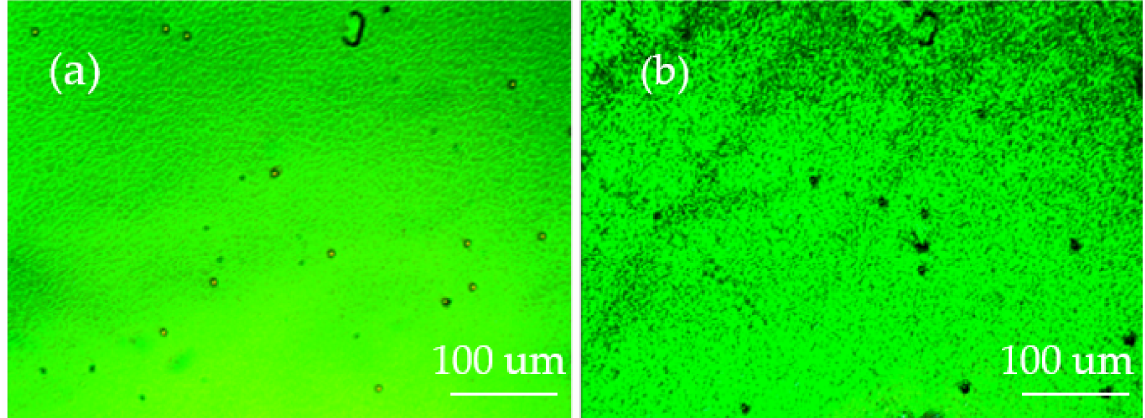
Figure 2. The surface morphology of ( a ) PS-BPLC and ( b ) T-BPLC.